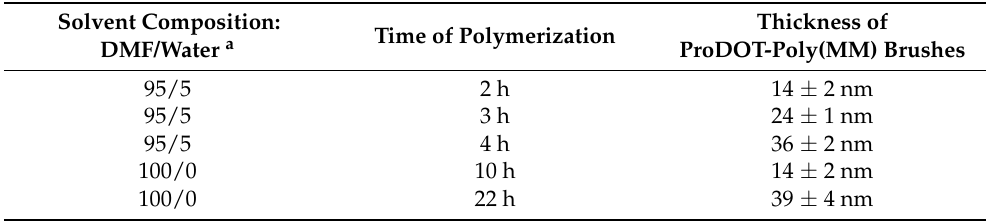
Table 1. Polymerization conditions, time and thickness of the ProDOT-Poly(MM) brushes grafted from ITO.